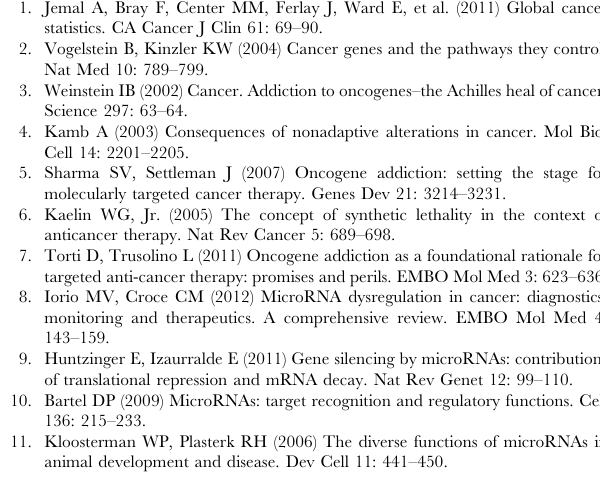
Table S3 Top 20 genes ranked by the fold enrichment score in Ago2-IP-seq with miRNA target predictions. Table S4 Significance of identified candidate targets for miR-195 and miR-497 through Ago2-IP-seq, expression array experiments, and statistical analyses. Table S5 Primer sets for q- gPCR, promoter assay, bisulfite sequencing, and ChIP-PCR. determined by function-based